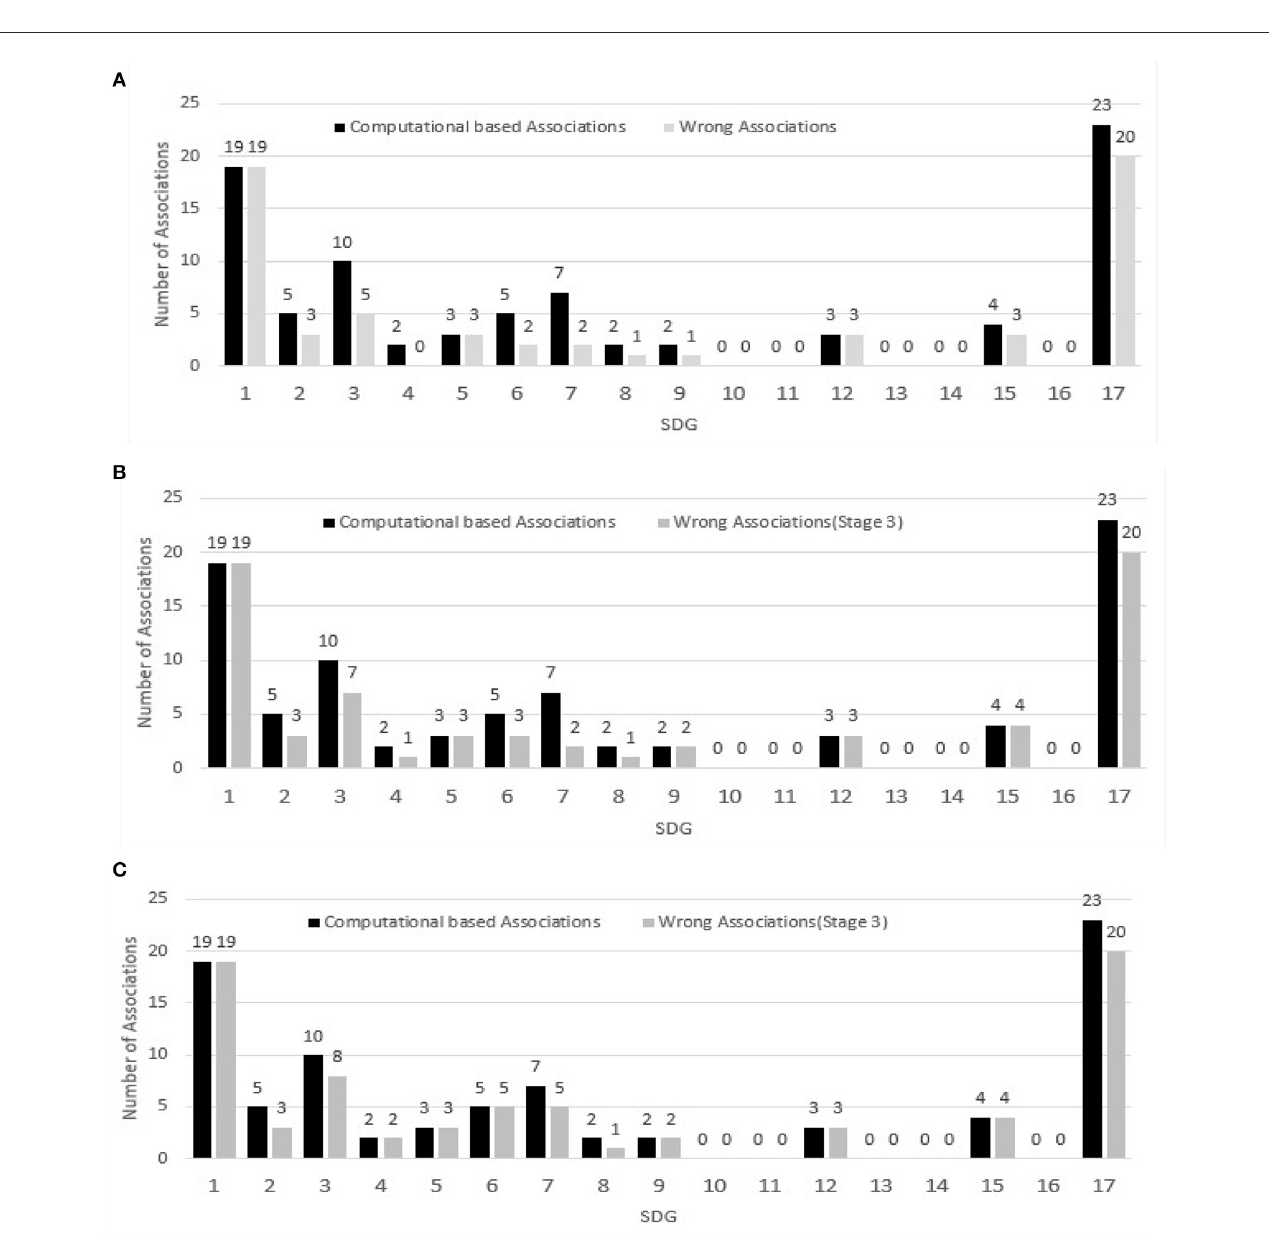
FIGURE3 Incorrect SDG associations vs. computational based associations for sustainability focused modules with high confidence. Stage 1, 2, and 3 correspond to the review of module description, learning outcomes and module aims respectively. (A) SDG associations from Stage 1 of manual review. (B) SDG associations from Stage 2 of manual review. (C) SDG associations from Stage 3 of manual